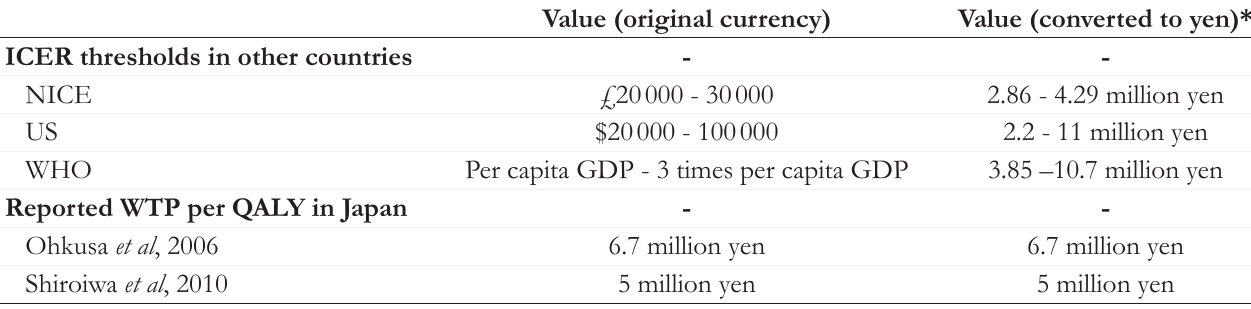
Table 9. ICER Thresholds in other Countries and the Reported Willingness to Pay per QALY in